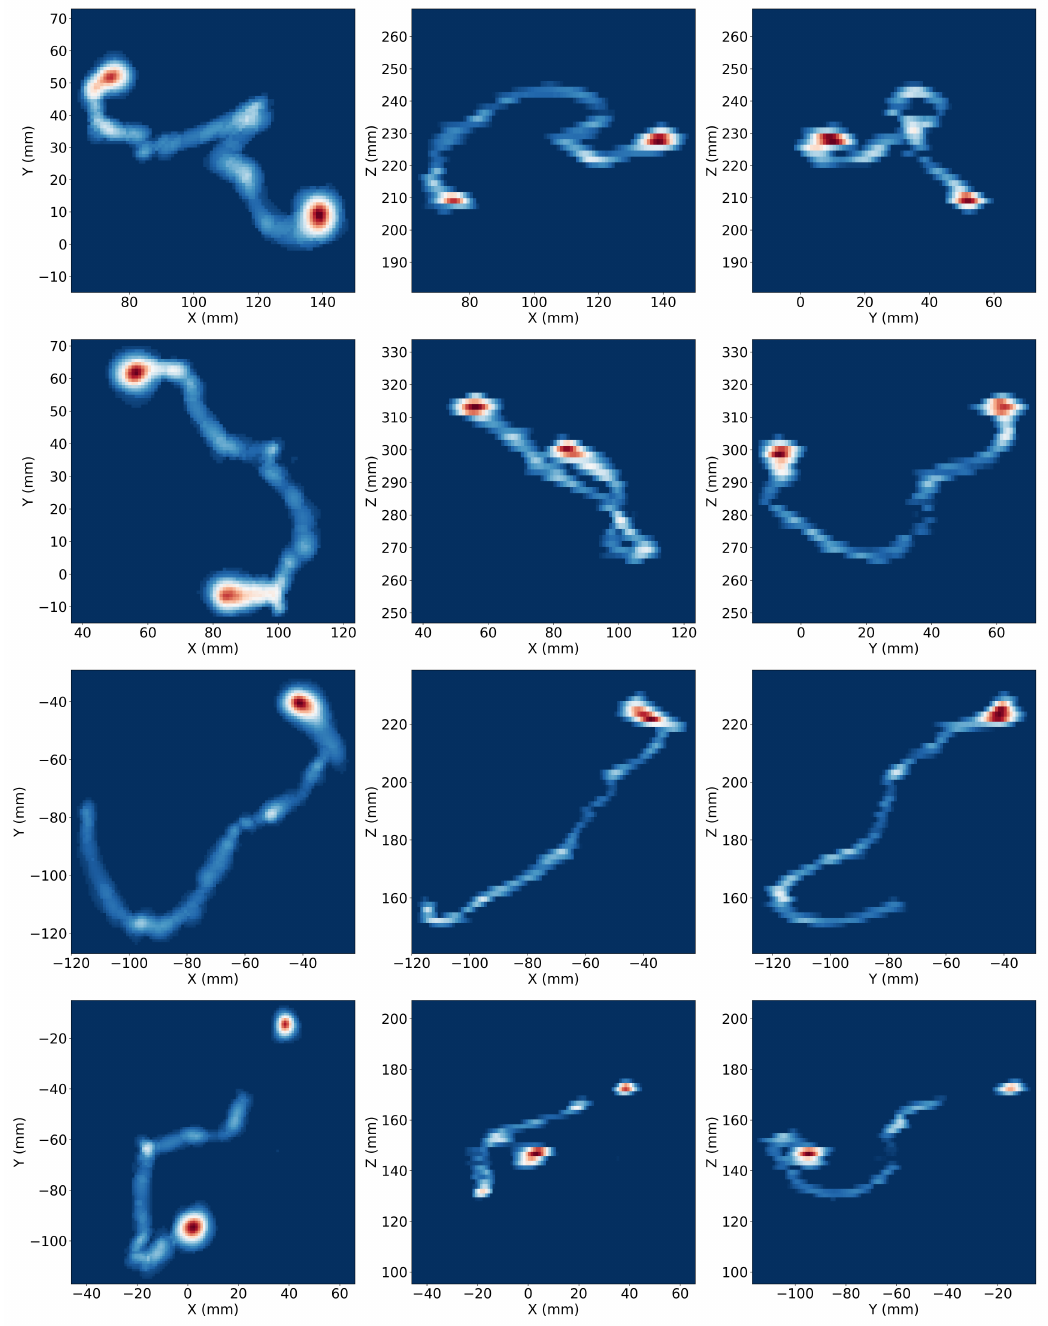
Figure 11 . Experimental detector data events in the 1.6 MeV double escape peak region after topological classification. Top two rows: e − e + candidates; bottom two rows: background candi-